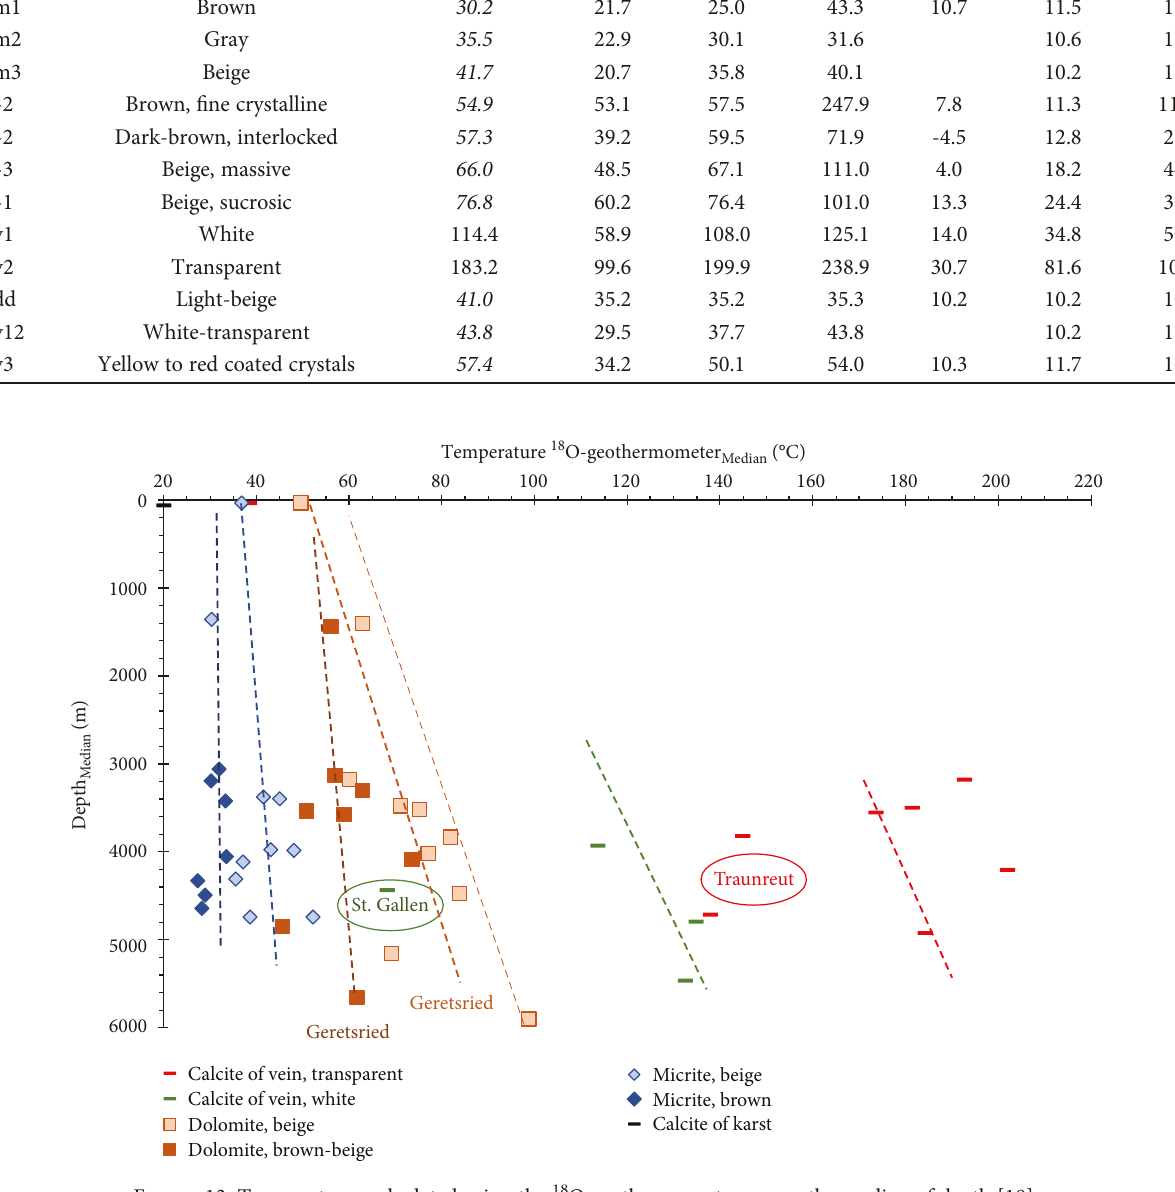
Figure 13: Temperatures calculated using the 18 O geothermometer versus the median of depth